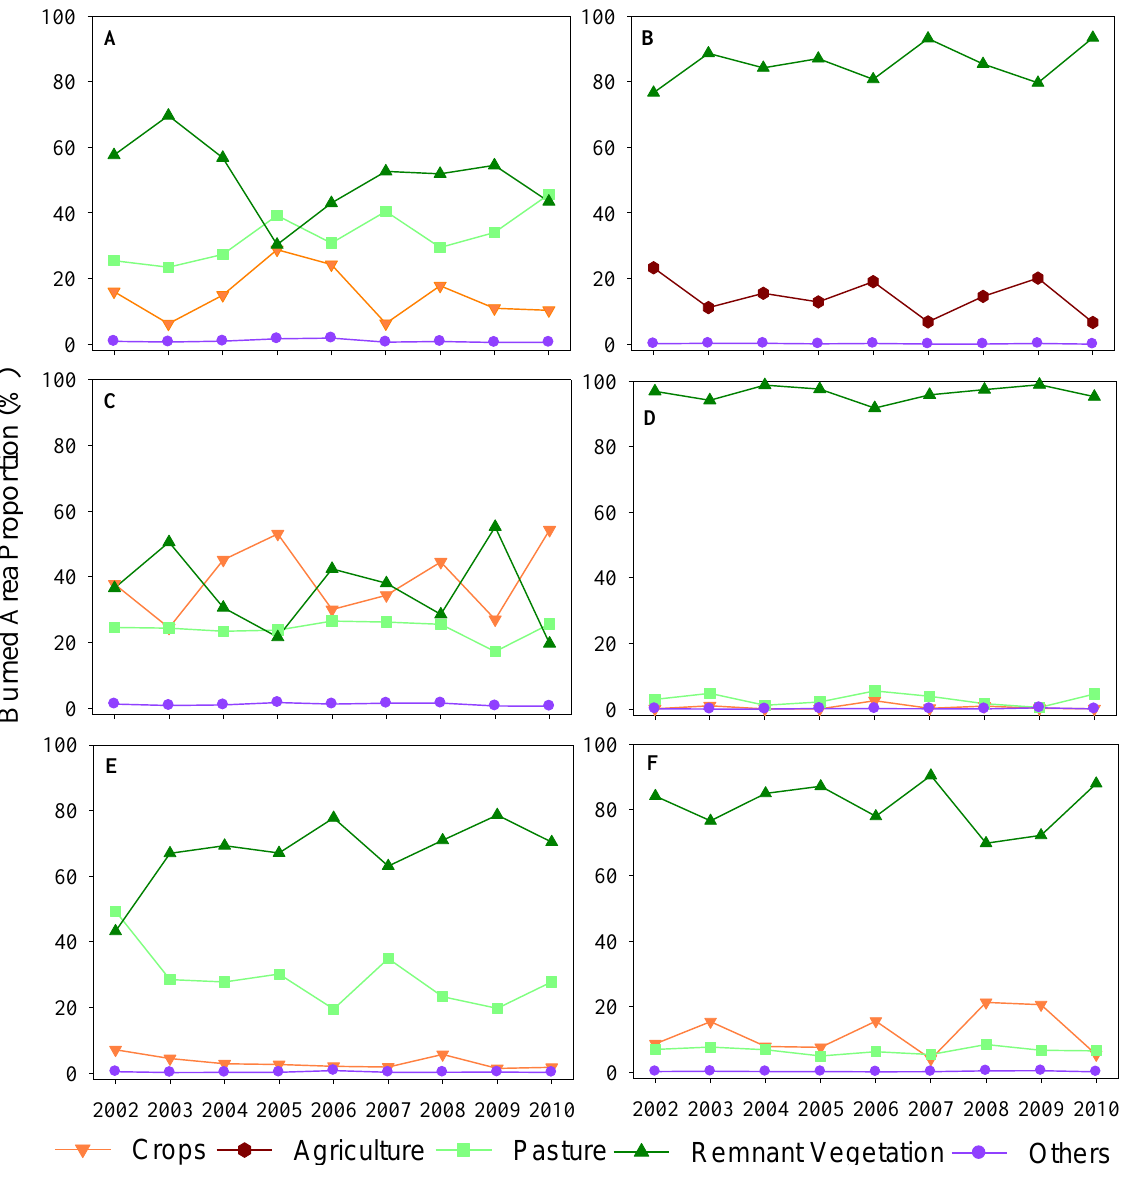
Figure 10. Distribution of burned areas (%), according to the major land cover classes, in the six Brazilian biomes (2002 to 2010): ( A ) Pampa; ( B ) Caatinga; ( C ) Atlantic Forest; ( D ) Pantanal; ( E ) Amazon, and ( F )